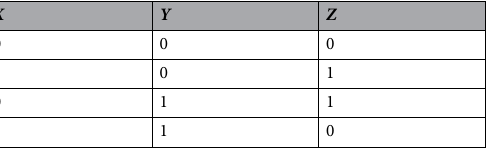
Table 2. Truth table for an Exclusive OR (XOR) gate, where the inputs are X and Y , and the output is Z